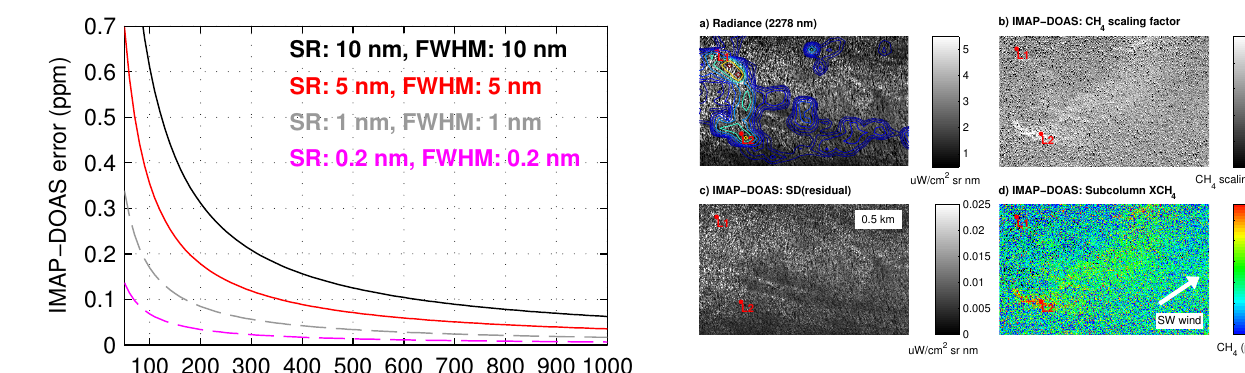
Fig. 7. (a) Measured radiance at 2278nm, showing strong variabil- ity in brightness. Sonar return contours (Leifer et al., 2010) are overlain and correspond to known seep locations. (b) For the same image subset, CH 4 scaling factor for the lowest atmospheric layer (layer 10) indicates a CH 4 plume consistent with the local wind di- rection. (c) The standard deviation of the residuals (measured minus modeled radiance) depends strongly on brightness (a) . (d) Subcol- umn XCH 4 (ppm CH 4 for the lowest layer), excluding bright pixels (greater than 5uWcm − 2 sr − 1 nm − 1 in the fitting window) associ- ated with high standard deviation of the residuals. For two spectra (indicated by locations L1 and L2), measured and modeled radiance are provided in Fig.